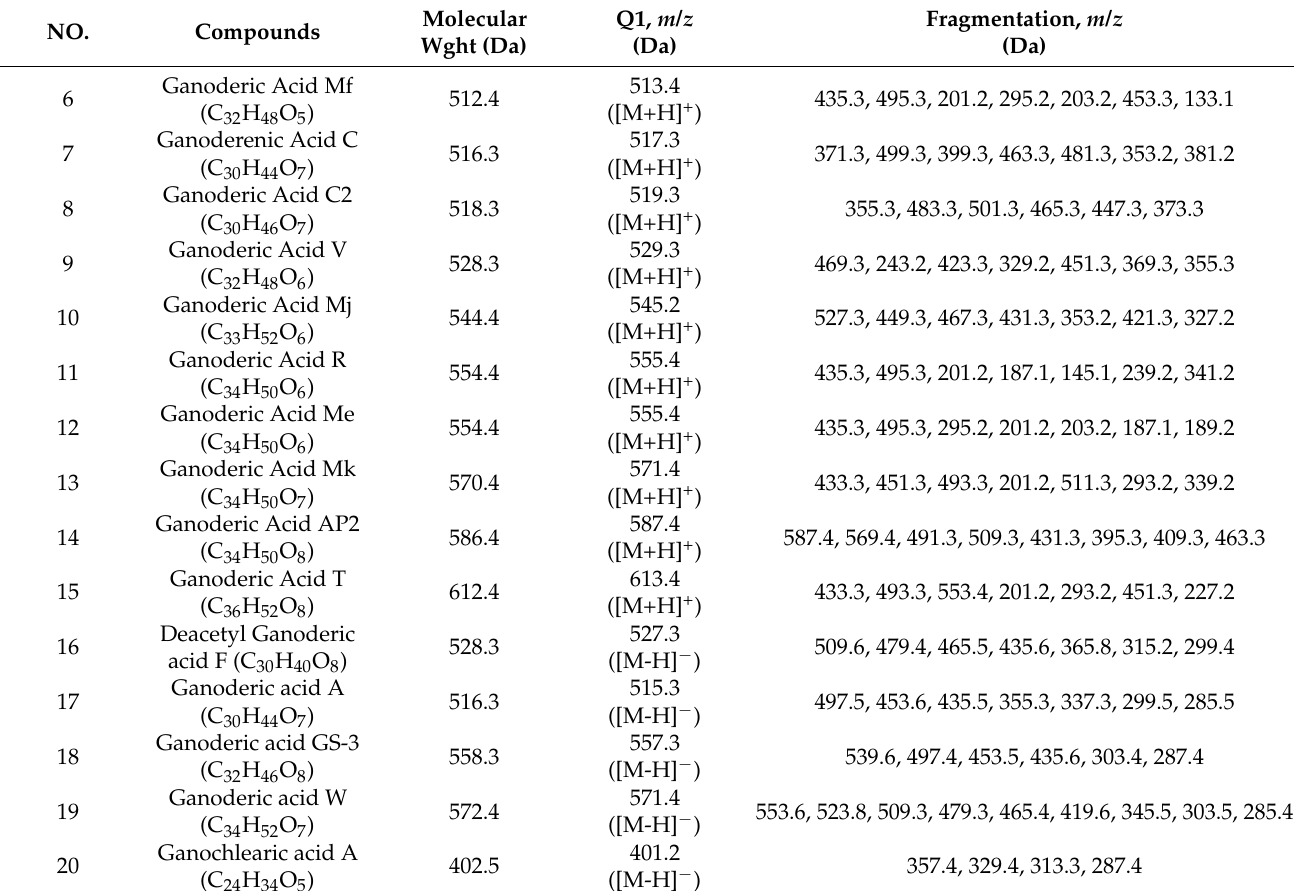
Figure 6A, alternative 5 (cid:48) first exon (transcription start site, TSS) splicing and alternative 3 (cid:48) last exon (transcription terminal site, TTS) splicing were the most frequent AS events. Multi-skipped exon (MSKIP), approximate multi-intron retention (XMIR), and approximate multi-exon skipped exon (XMSKIP) were the AS events with less frequency. Venn